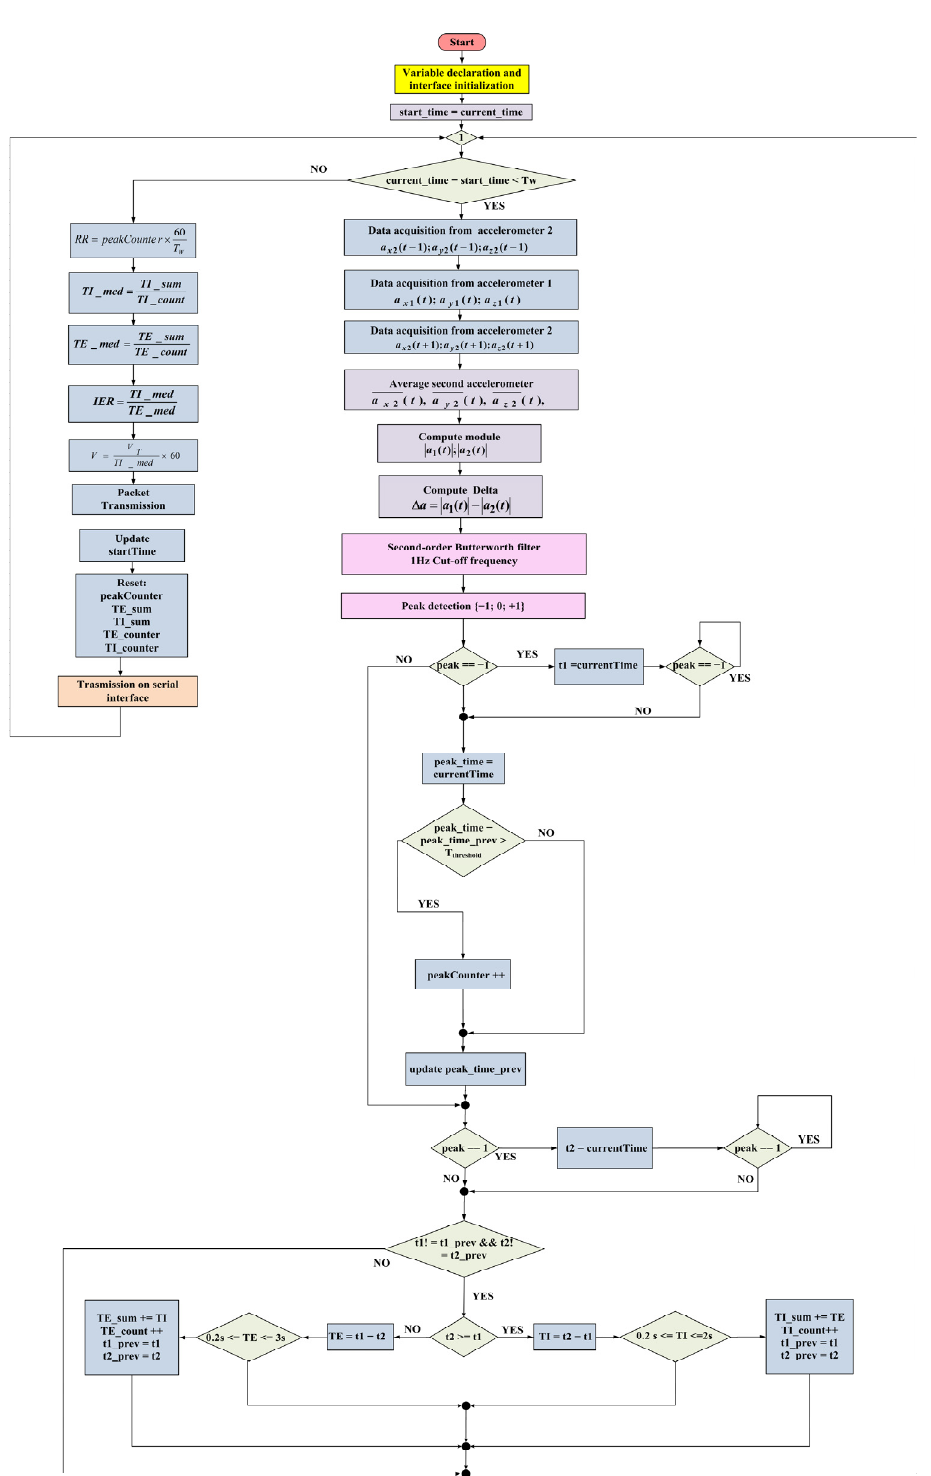
Figure 5. Flowchart of firmware implemented in the inertia-based chest